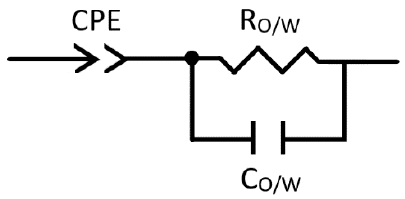
Figure 2. Equivalent circuit of O / W Pickering emulsion. Table 1. Fitted value and error of the parameters of Pickering emulsion equivalent circuit. Parameter Fitted